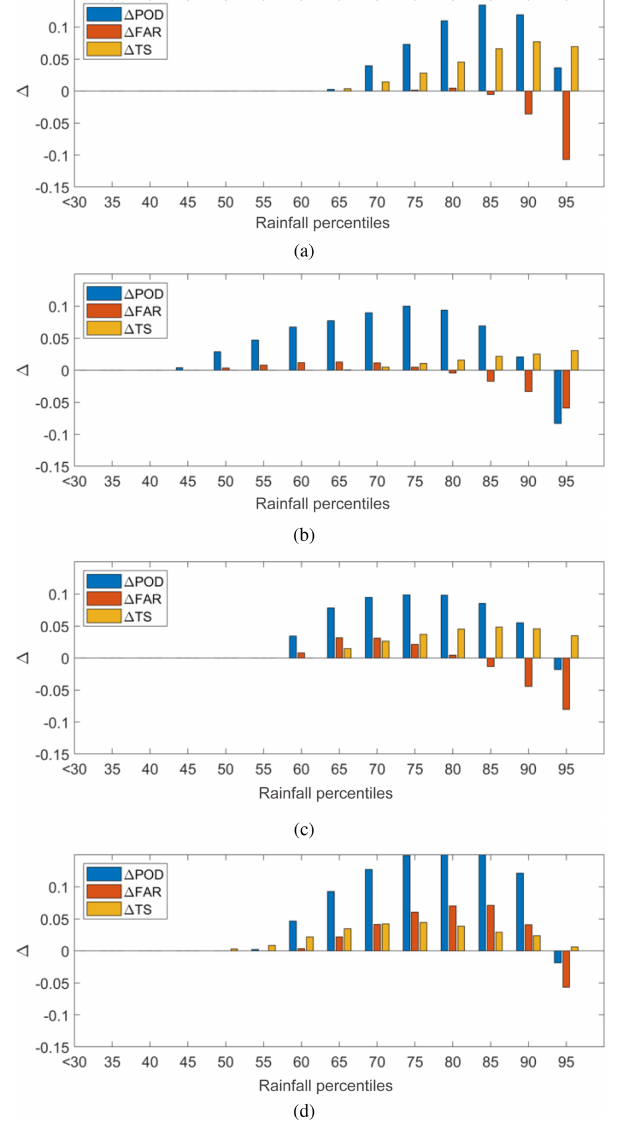
Figure 7. Difference in categorical indices (probability of detection – POD, false alarm ratio – FAR – and threat score – TS) between the integrated product P R + SM and the IMERG-ER as a function of the rainfall classes for Australia (a) , CONUS (b) , Europe (c) and India (d) for the period 2015–2017. The bars refer to median values.